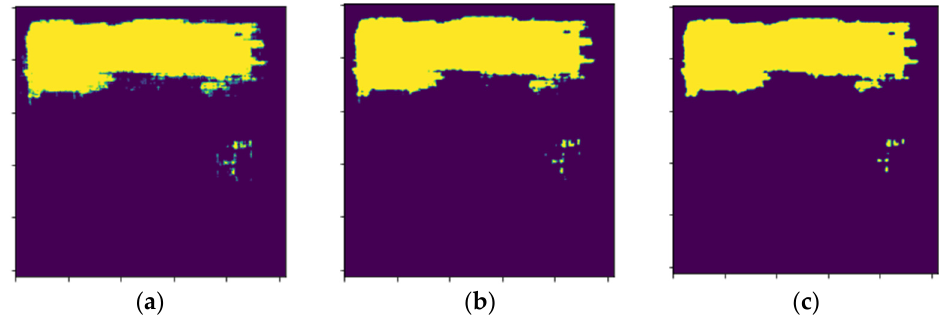
9 of 14 ( d ) Figure 10. Results of trained networks: ( a ) UNet; ( b ) MobileNetV2; ( c ) VGG16; ( d ) YOLOv4-tiny. It is evident from Figure 9 that Unet and MobileNetV2 correctly determine the seg- ment position, but when selecting it, they make mistakes, not highlighting parts from the